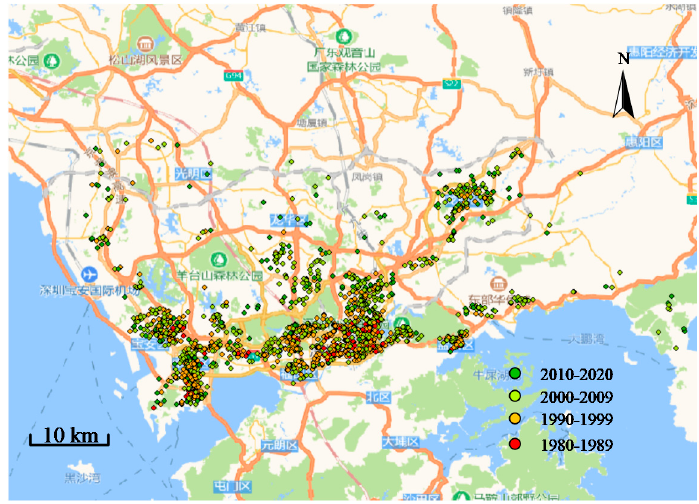
Figure 12. Distribution of year of built in the area.